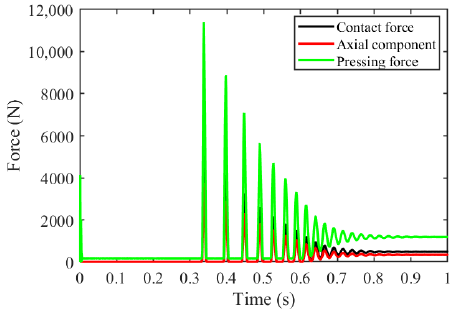
Figure 10. Dynamic features of ball ‐ and ‐ socket contact pair under reverse load.